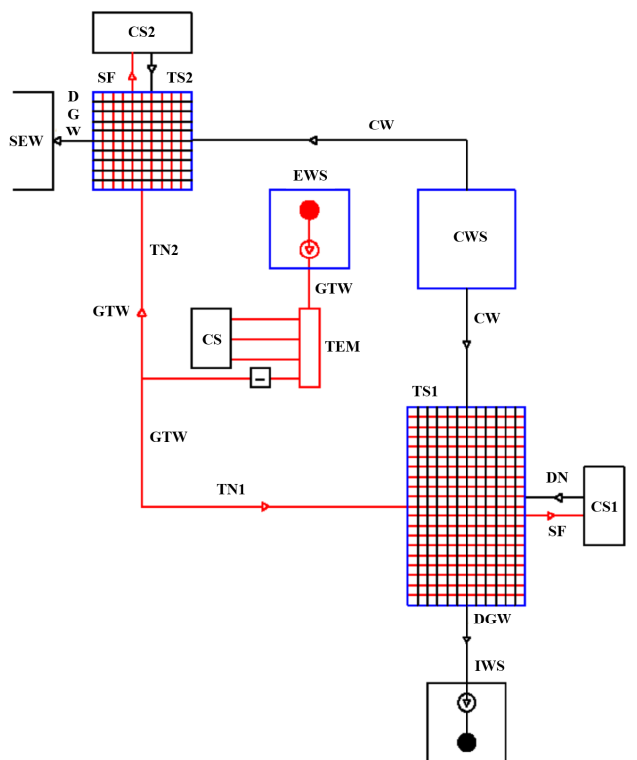
Figure 1. HSGWPE diagram: EWS—geothermal extraction well station; IWS—injection well station;